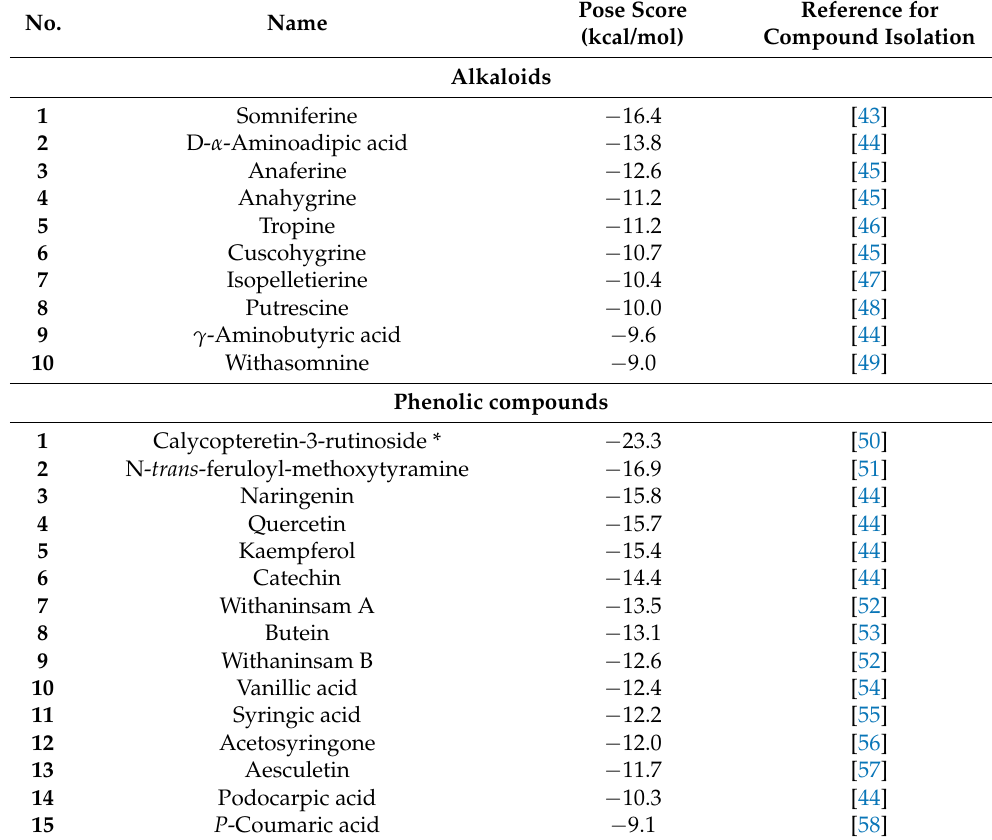
Table 2. List of the compounds isolated from W. somnifera along with their molecular docking results.